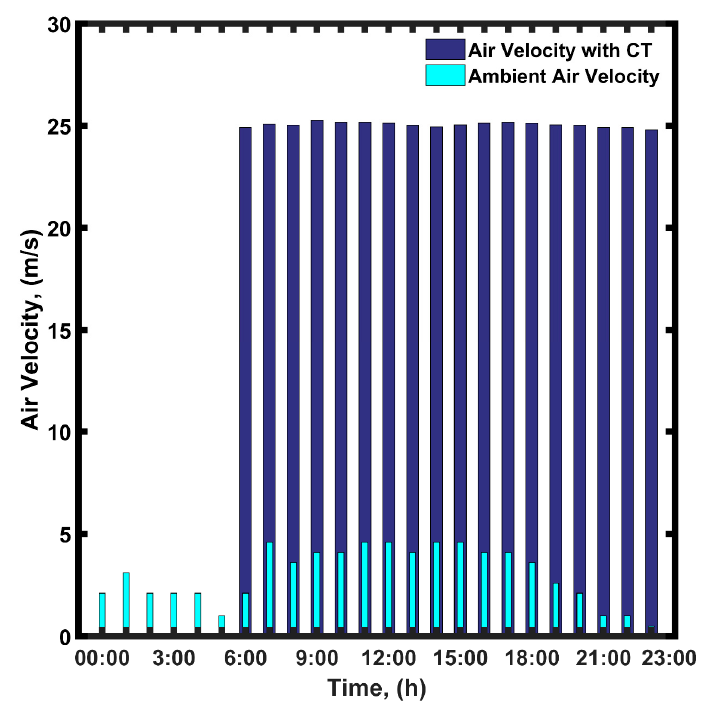
Figure 5. Profiles of the wind speed of the air under the PV panels with and without the CT.